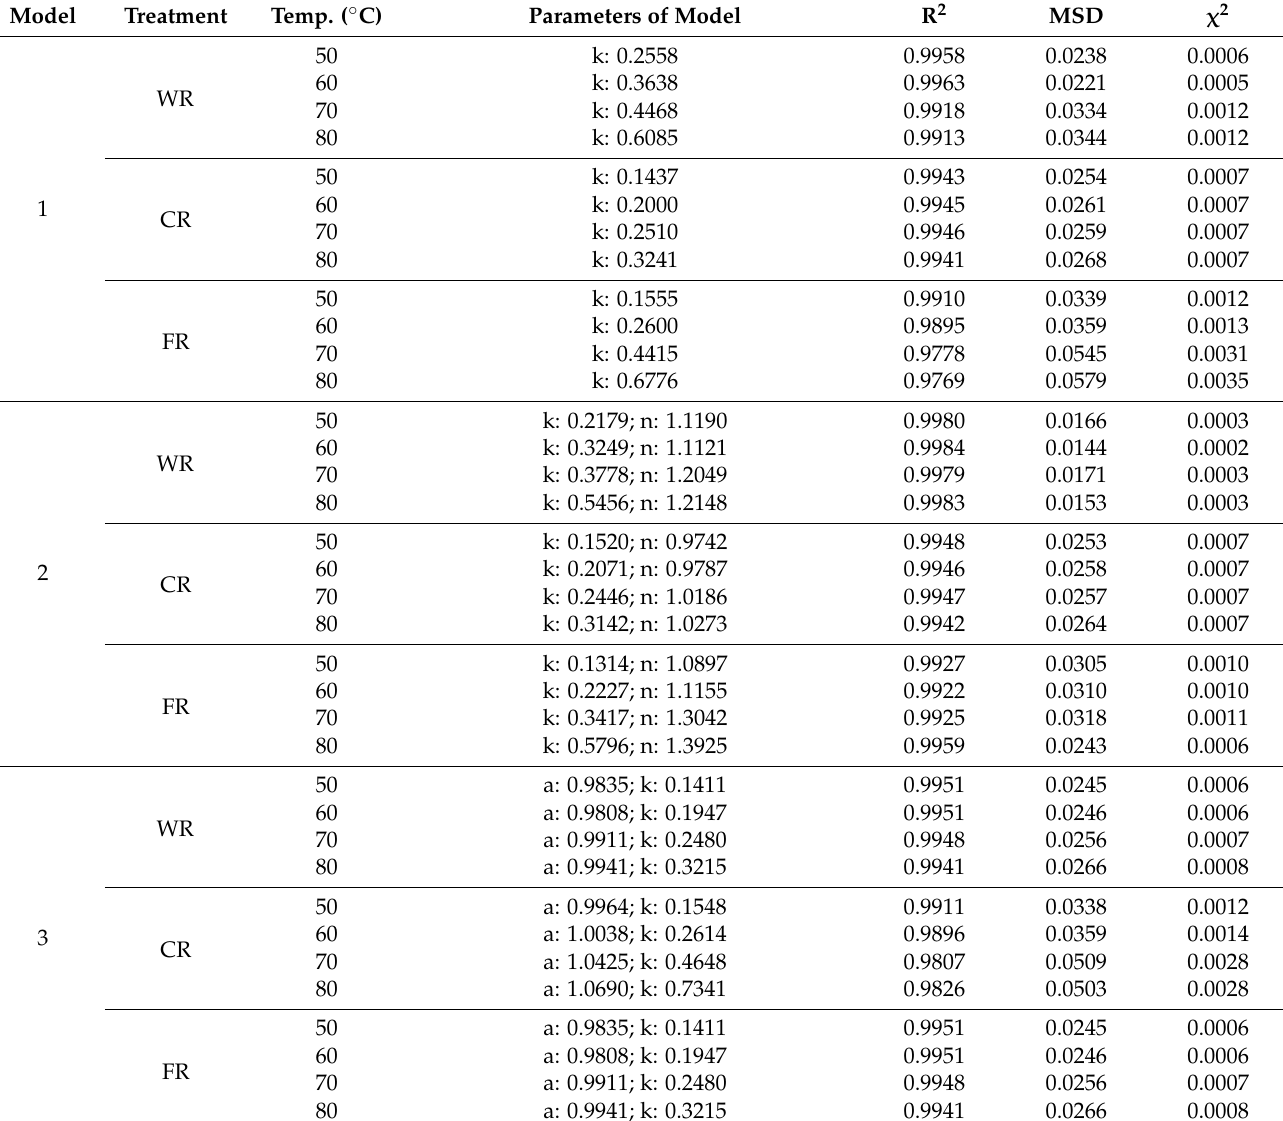
Table 2. Results of statistical analyses for models fitted to the convective drying kinetics data of whole residue (WR), crushed residue (CR) and residue in the form of foam (FR).